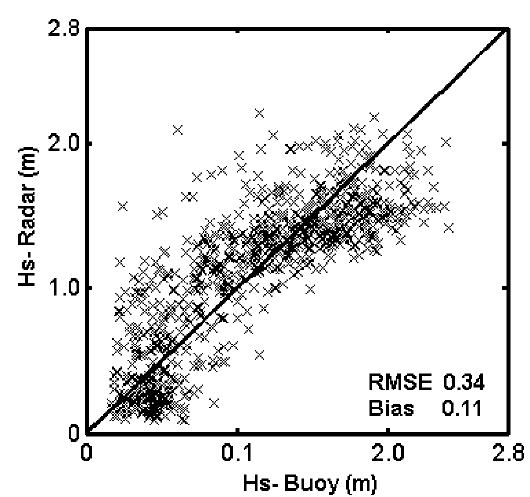
Figurer 3. Root mean square error (RMSE) between the Hs values that were obtained by the buoy and the